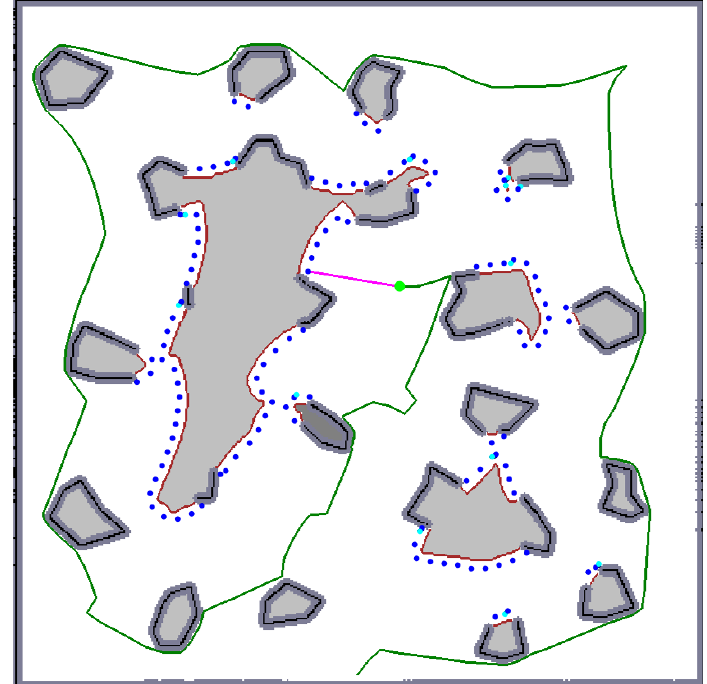
Figure 4. An exploration step: the robot (the green circle) selects one of the goal candidates (the blue dots; note that two different hues are used to visually distinguish overlapping dots.) as a next goal and plans a path to it (the pink curve). The green curve represents the already traversed